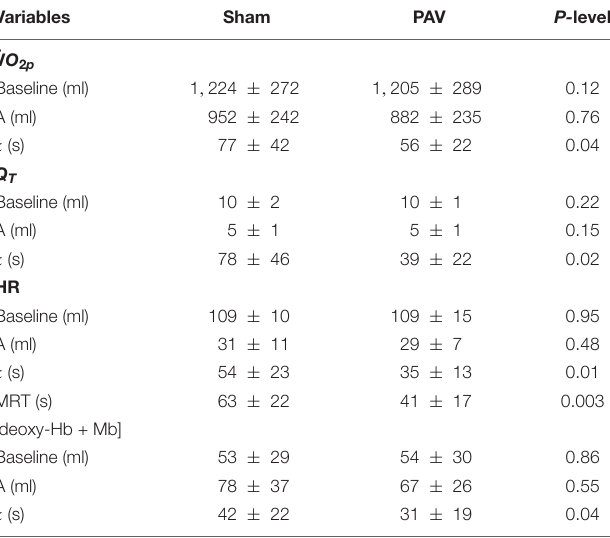
TABLE 3 | Off-exercise kinetic parameters for oxygen uptake (˙V O 2 p ), [deoxy-Hb/Mb], and cardiac output (Q T ) after sham or proportional assist ventilation (PAV) ( N =